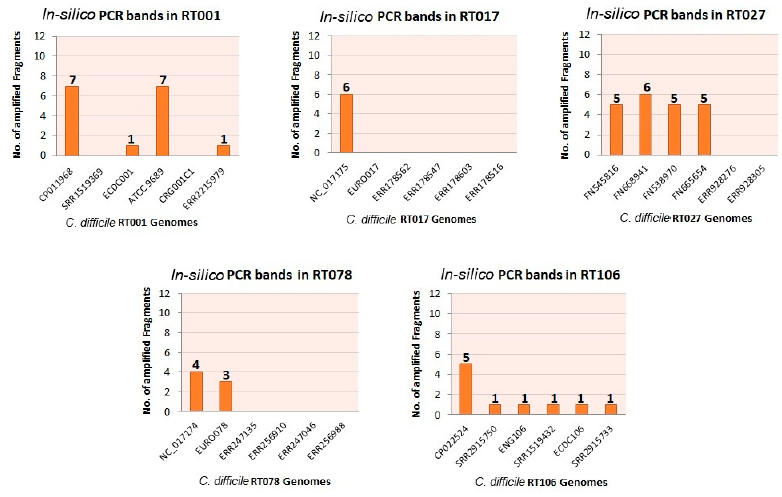
Figure 1. In silico ribotyping of different C. difficile genome sequences using the ISR 16S and 23S USA primer pair. The five panels represent the results obtained for examples of five different ribotypes. Bar graphs show the number of theoretical PCR bands (vertical axis, number of bands labeled on each bar) in the ribosomal region of respective genome sequences (horizontal axis), whereas the genomes without any fragments depict the complete absence of primer binding sites in those genomes. Note that the expected outcome would be an identical number of fragments for each of the strains belonging to a single ribotype. We indicated this number as the first marker of reproducibility; it has to be stated that besides this variation of numbers of fragments, the size of the fragment was also determined as a variable as well.